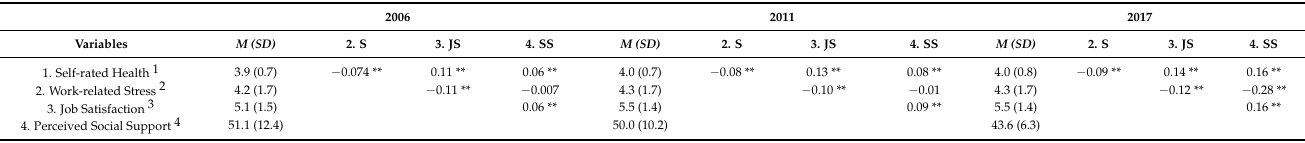
Table 2. Descriptive statistics and correlations of the criterion: self-rated health; predictor: work-related stress; and mediating variables: job satisfaction and perceived social